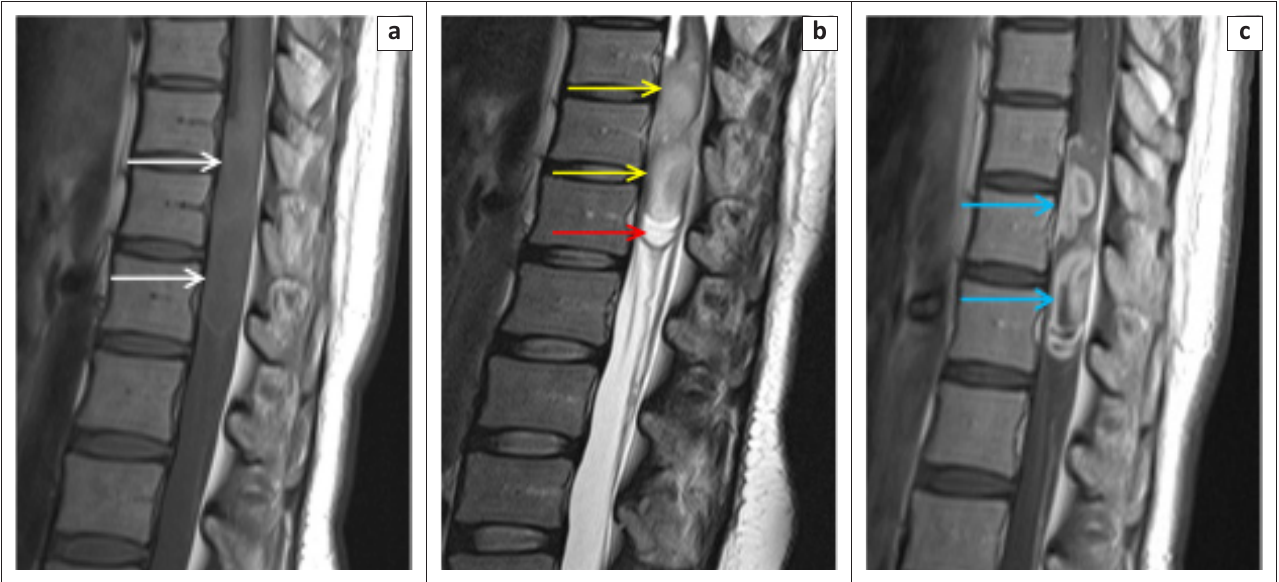
FIGURE 3: A rare case of intramedullary conus medullaris glioblastoma multiforme in a 37-year-old woman. Sagittal T1-weighted image (a) demonstrates isointense, irregular expansion of the conus medullaris (white arrows). Sagittal T2-weighted image (b) reveals abnormal hyperintensity throughout the expanded region (yellow arrows) and an associated tumoural cyst (red arrow). Contrast-enhanced sagittal T1-weighted image (c) displays irregular, intense enhancement of the glioblastoma multiforme (blue